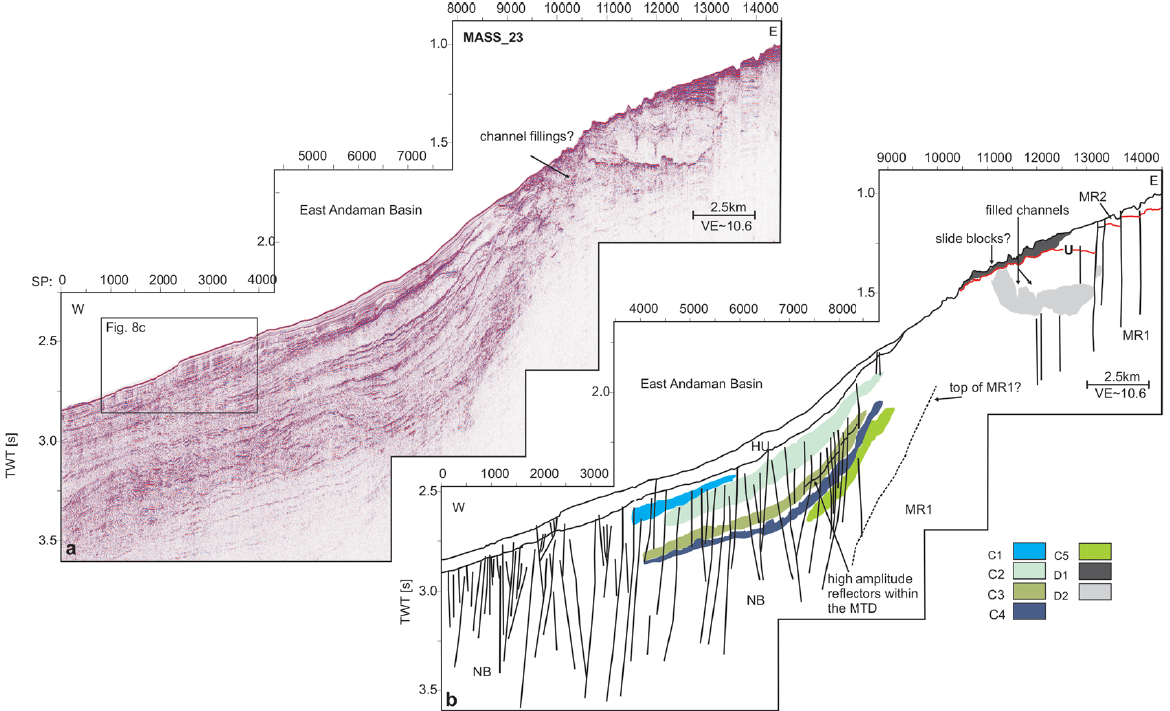
Fig. 7. (a) Slope normal seismic line MASS 23 from the basin ridge transition in the northern working area with channel fillings indicated at the edge of Mergui Ridge (b) Interpreted profile, showing seismic units of Mergui Ridge in the east (MR1, MR2) and seismic units of basin sediments in the west (HU, NB). The black lines indicate boundaries between units. The red line marks the position of unconformity U . The black dashed line marks a possible top boundary of MR1 towards the basin. The vertical lines indicate fault positions. The colored areas mark the stacked MTDs C1–C5 in the basin area and MTDs D1 and D2 on Mergui Ridge. See Figs. 2 and 3 for location of profile and text for further